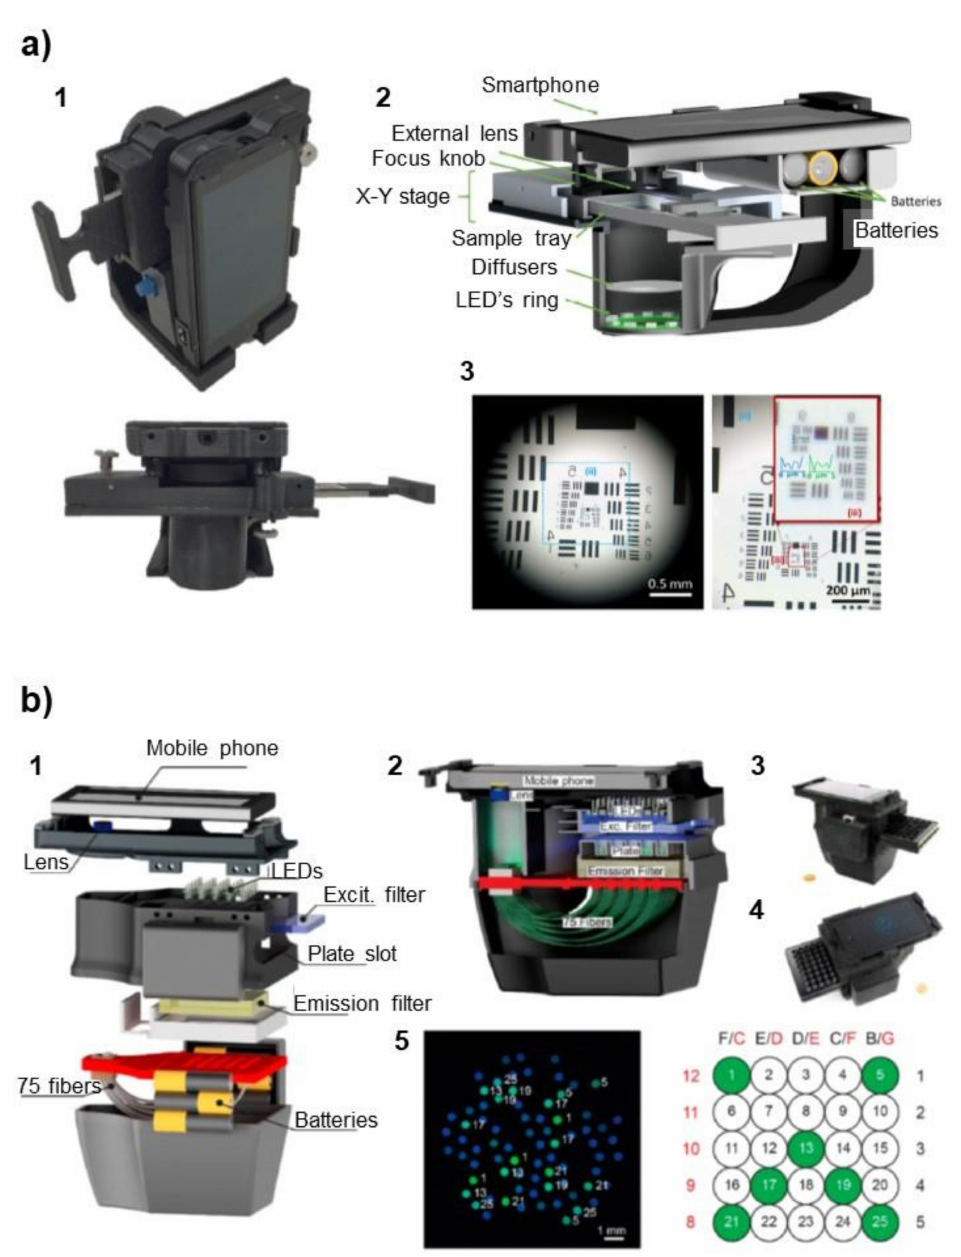
Figure 5. ( a ) Design of the smartphone microscope reported by Rivenson et al. 2018 (adapted with permission from